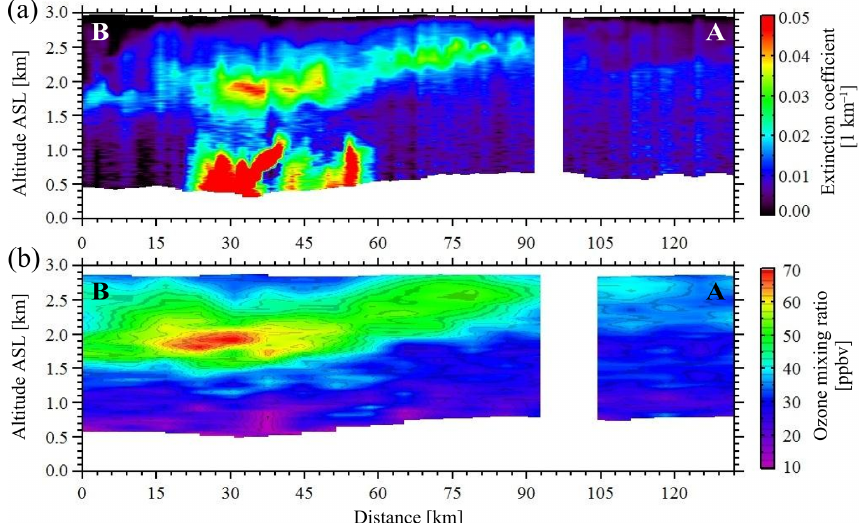
Figure 12. (a) The aerosol extinction coefficient measured at a wavelength of 532nm and (b) the O 3 mixing ratio derived from the lidar measurements for the flight segment A–B on 24 August 2013. The lidar measurements were collected between 14:48 and 15:18 local time (UTC − 6h). The height is above sea level (a.s.l.). Distance is from point B along the flight segment in Fig. 11. The blank section in this figure represents a region where clouds interfered with the lidar